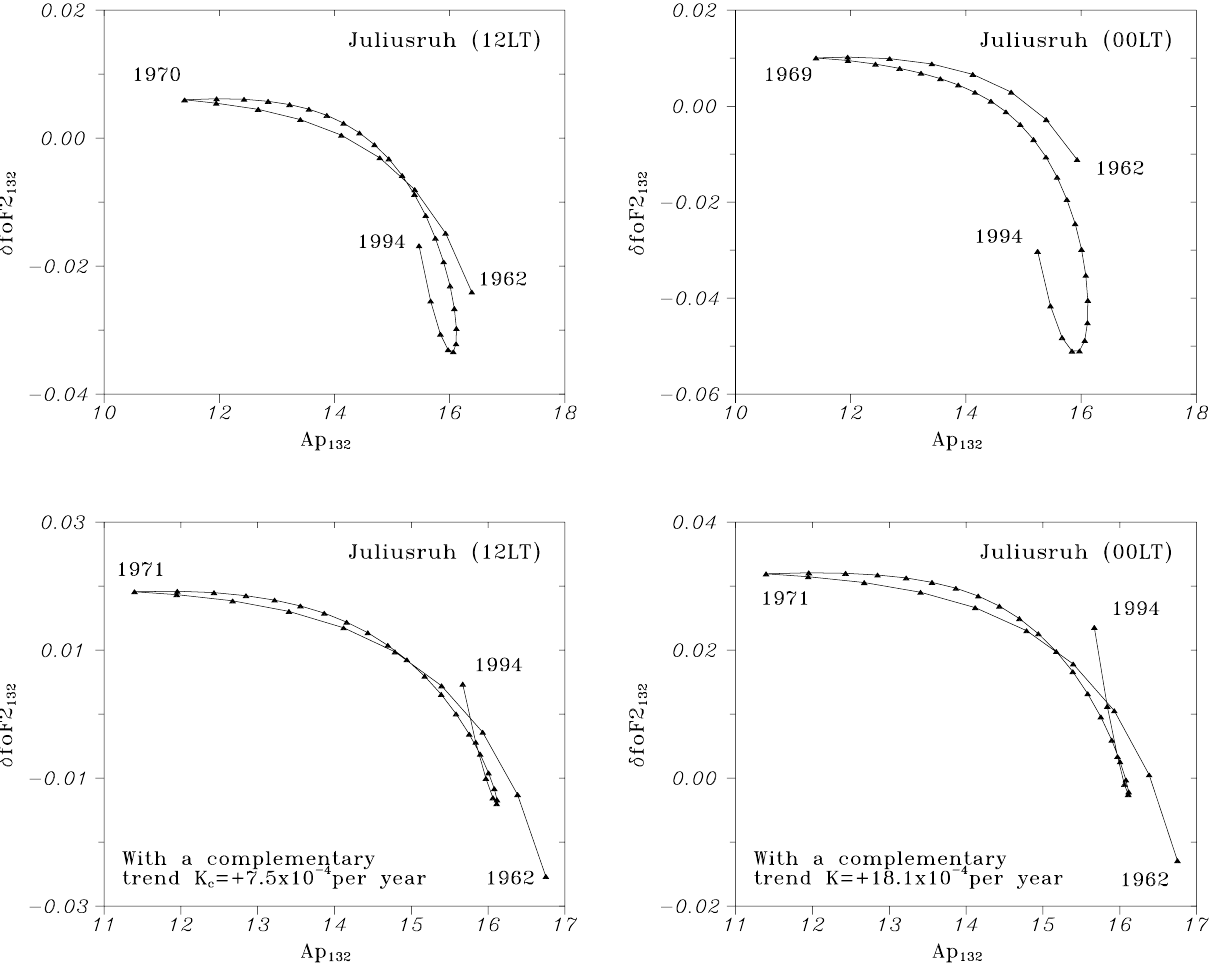
Fig. 4. Relationship between polynomial approximated δ fo F2 132 and Ap 132 for Juliusruh (12:00 and 00:00LT) (top panels) and the same dependencies after applying a complementary trend (bottom). Note the tightening of the loops in the second case.